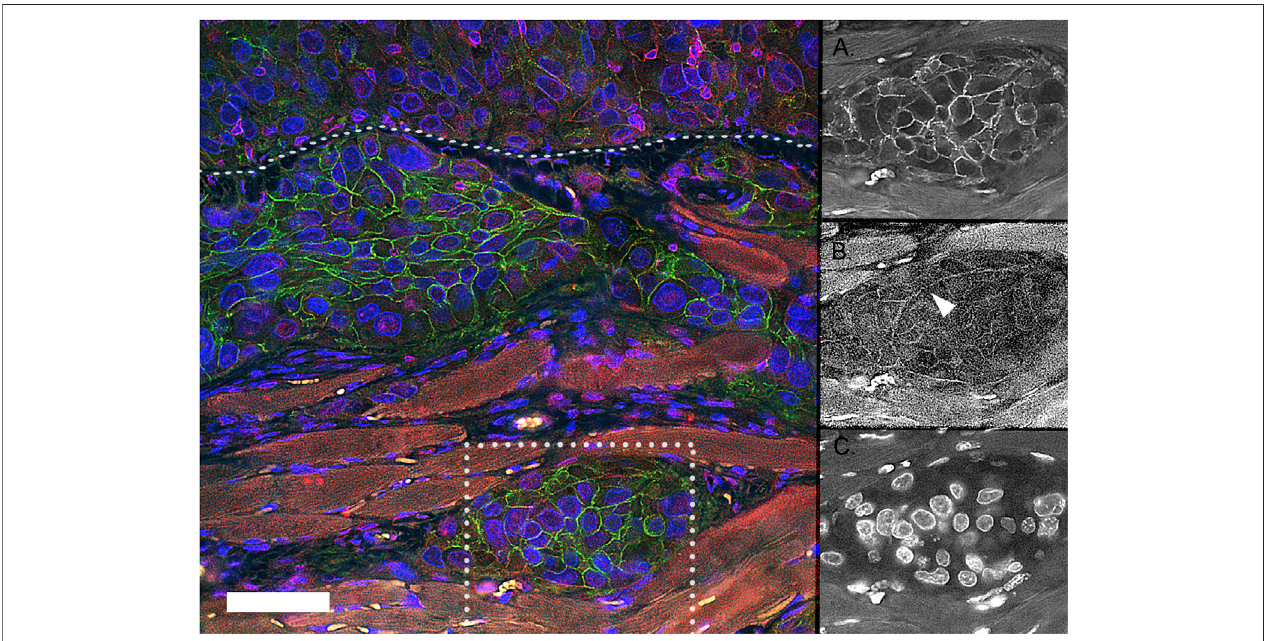
FIGURE1| ExpressionofE-cadherinand α 6integrininmuscleinvasivetumornetworksinmousexenograftmodel.DU145humantumorcellswereIPInjectedinto a SCID mouse. The resulting human tumor grows on top of and invades through the muscle diaphragm surface (white dotted line). The tumor clusters express E-cadherin (Green), α 6 integrin (Red) in spatially distinct cell-cell and cell-ECM regions, with no detectable overlap (Yellow). Blue = DAPI; Green = E-cadherin; Red = ITGA6(NT);theauto- fl uorescentmuscleisadullred.Theindividualimagechannelsofthetumorsplittingthemuscle(inthedottedwhitebox)areseparatedtoshow the distinct distribution of E-cadherin (A) , α 6 integrin (B) , and nuclei (C) . Scale bar = 50 um.